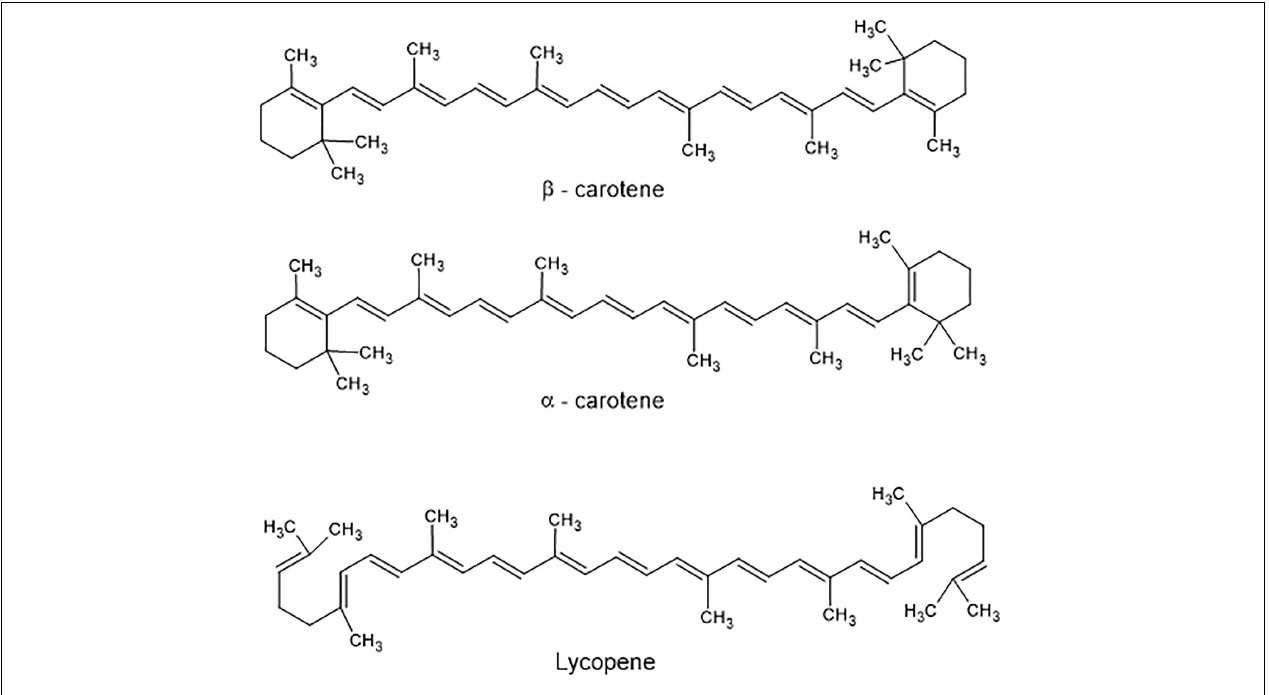
FIGURE 2 | Structure of main carotenes found in